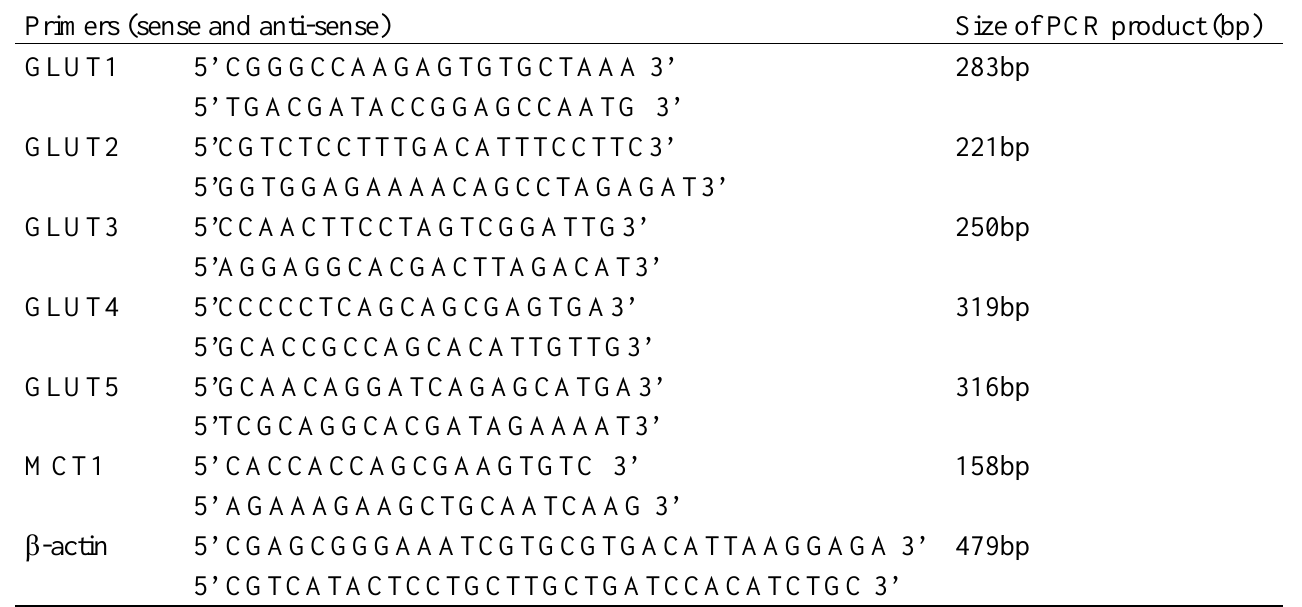
Table 1. The primers of GLUT1, MCT1 and β